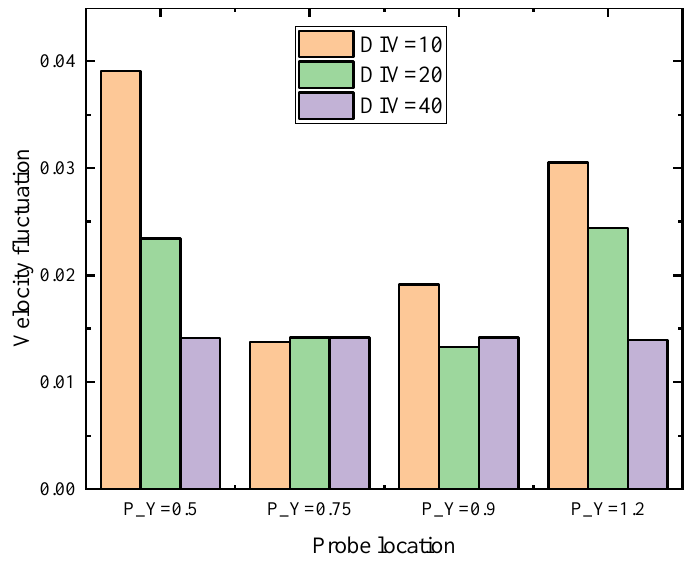
Figure 6. Magnitude of velocity fluctuation under different bubble density which is characterized by dividing bubbly flow region (inlet surface) into different random positions: DIV = 10, DIV = 20 and DIV = 40, respectively.